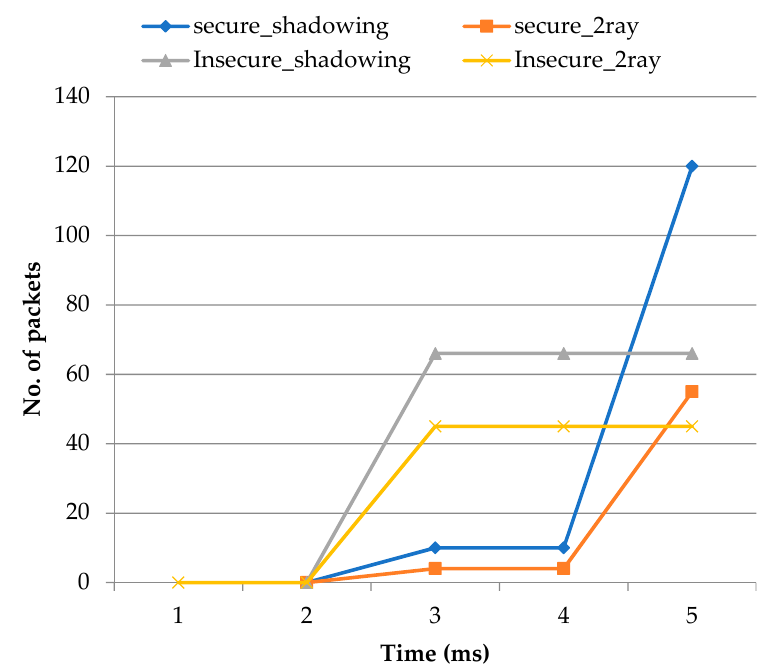
Figure 7. Throughput of flying nodes in the network. Table 6. The number of packets versus time in throughput parameter. Secure Vs. Insecure